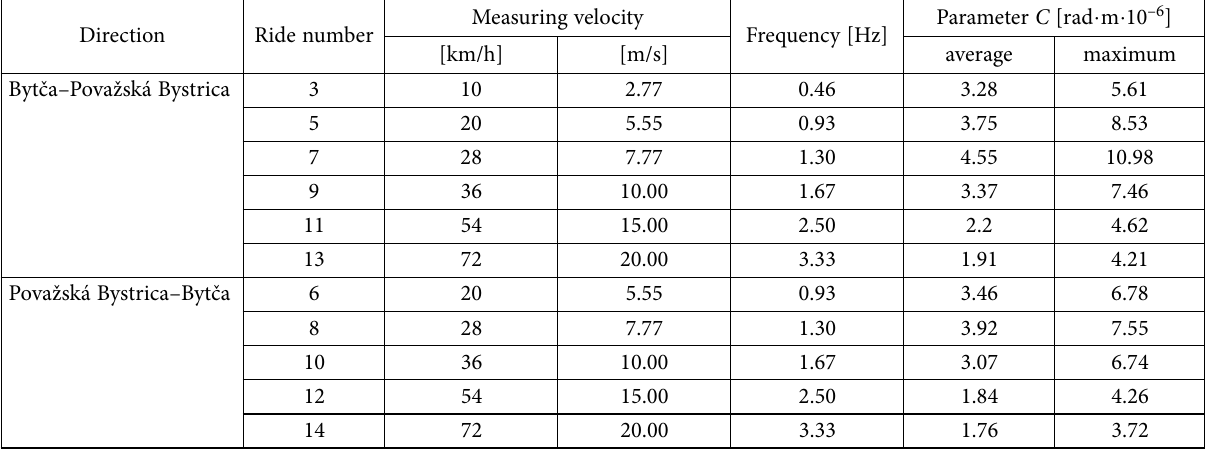
Figure 10. PSD of harmonic unevenness and stochastic unevenness of road section Čičmany Table 1. The results of the longitudinal unevenness measurements of road section